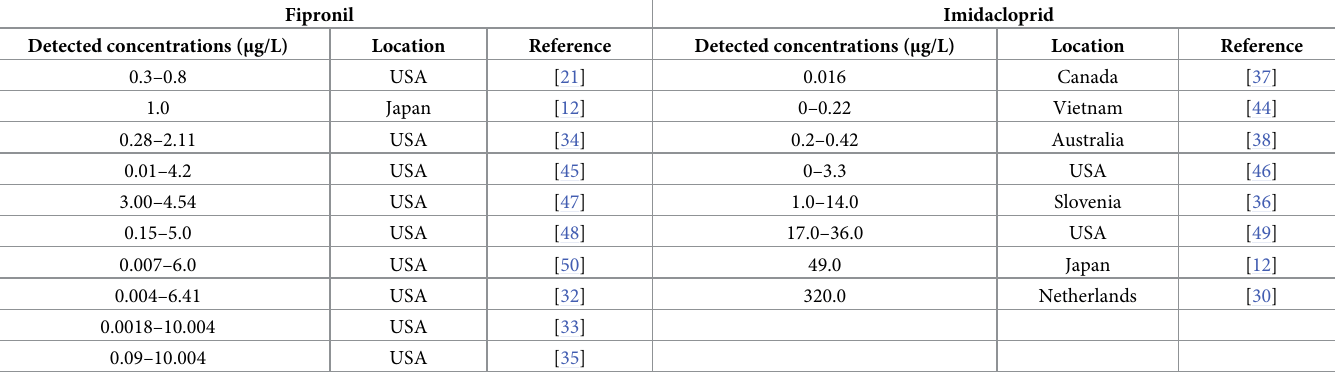
Table 1. Fipronil and imidacloprid concentrations observed in the aquatic environment and reported in previous studies. Fipronil Imidacloprid Detected concentrations ( μ